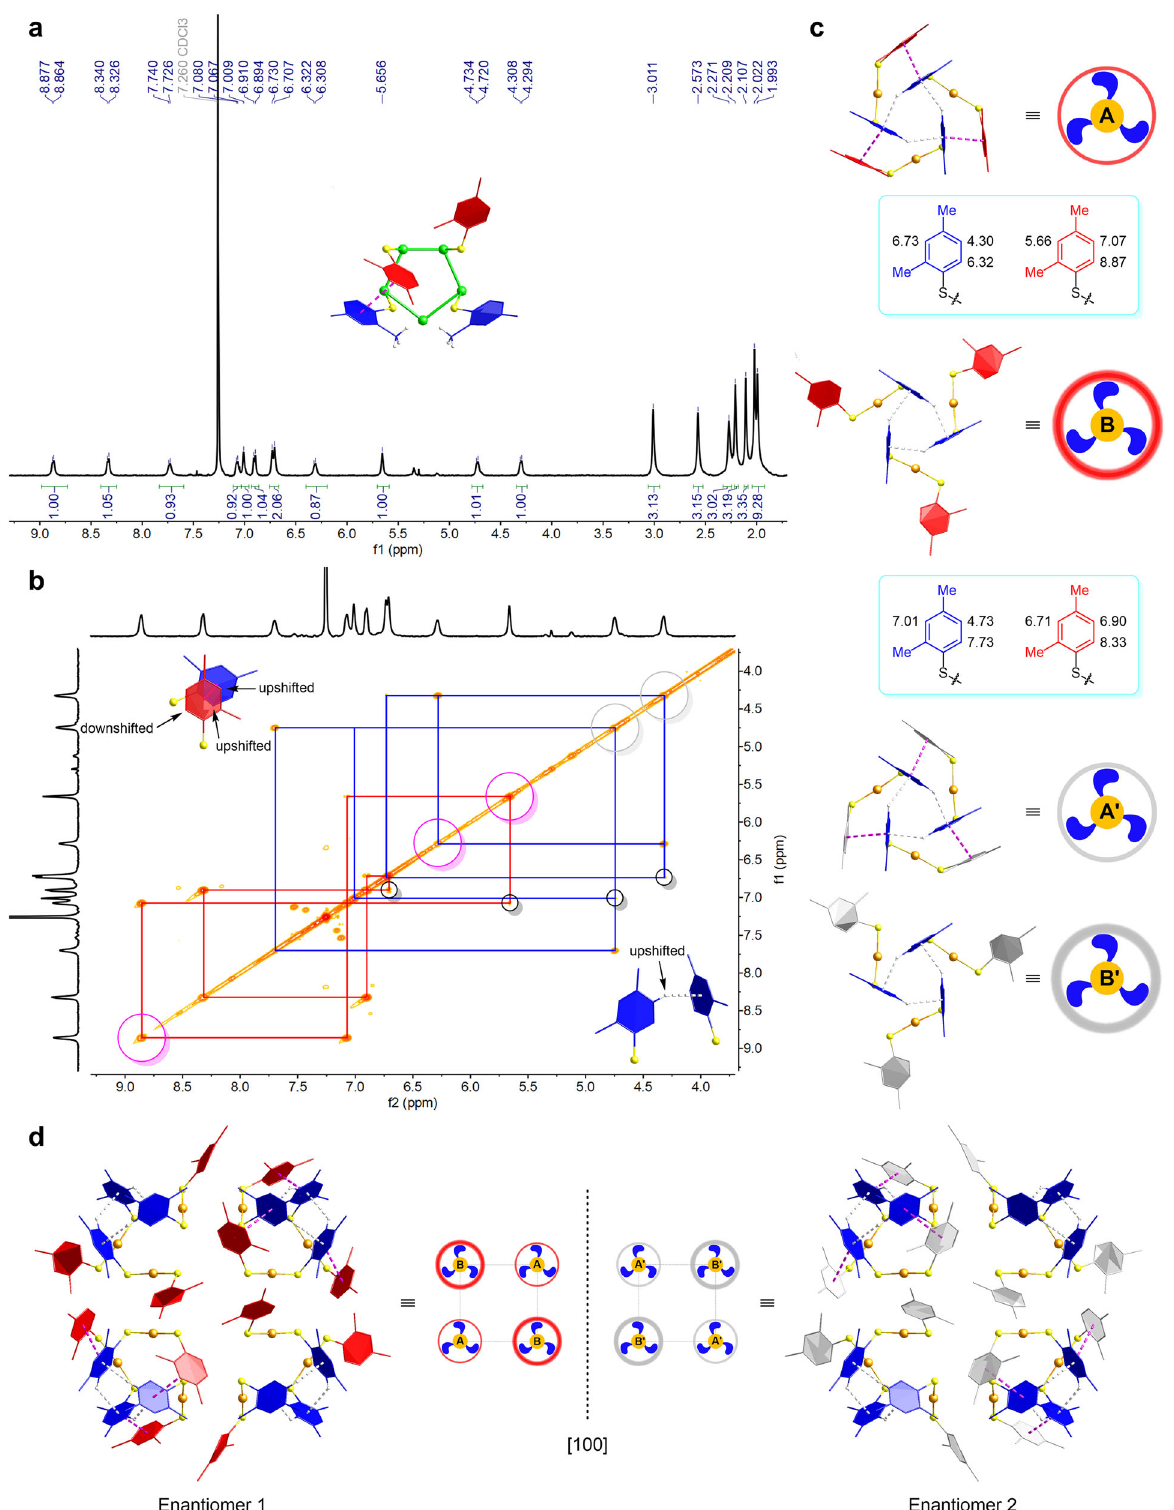
Fig.2|Analysisofaromaticthiolatesintheprotectiveshell.a 1 HNMRspectrum of Au 138 (SR) 48 in chloroform- d . b 1 H – 1 H COSY spectrum depicting the correlations between aromatic protons in four sets of 2,4-DMBT ligands. Pink and gray circles highlightprotonssigni fi cantlyin fl uencedby π – π stackingandC – H··· π interactions, respectively. Long-range couplings between protons at the 3- and 5-positions of aromatic rings are demonstrated by black circles. c Schematic illustration of 12 [ – SR – Au – SR – ] staples in two separate protective units with assigned signals of all aromatic protons. d Enantiomeric distributions of aryl groups on the